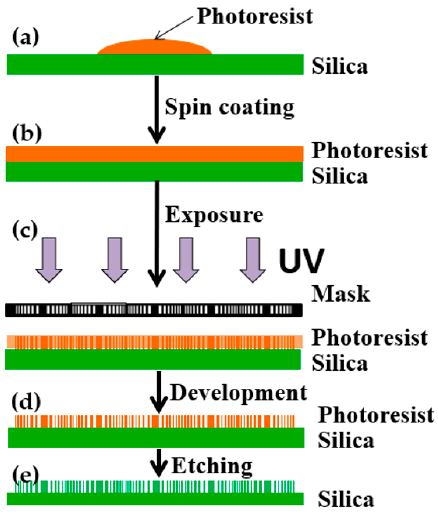
Figure 3. Preparation technology of multi-spectral ACE: ( a ) substrate preparation; ( b ) photoresist was spin-coated on the silica; ( c ) proximity exposure with designed mask; ( d ) photoresist-based structure was achieved after development; ( e ) the pattern was transferred to silica by etching.